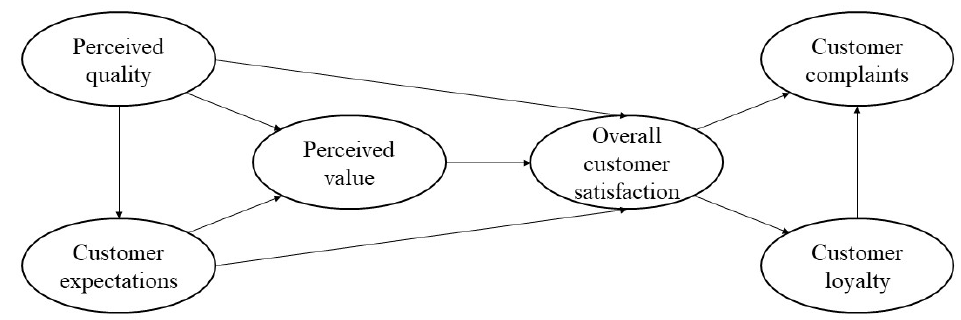
Figure 2. American Customer Satisfaction Index (ACSI) model.